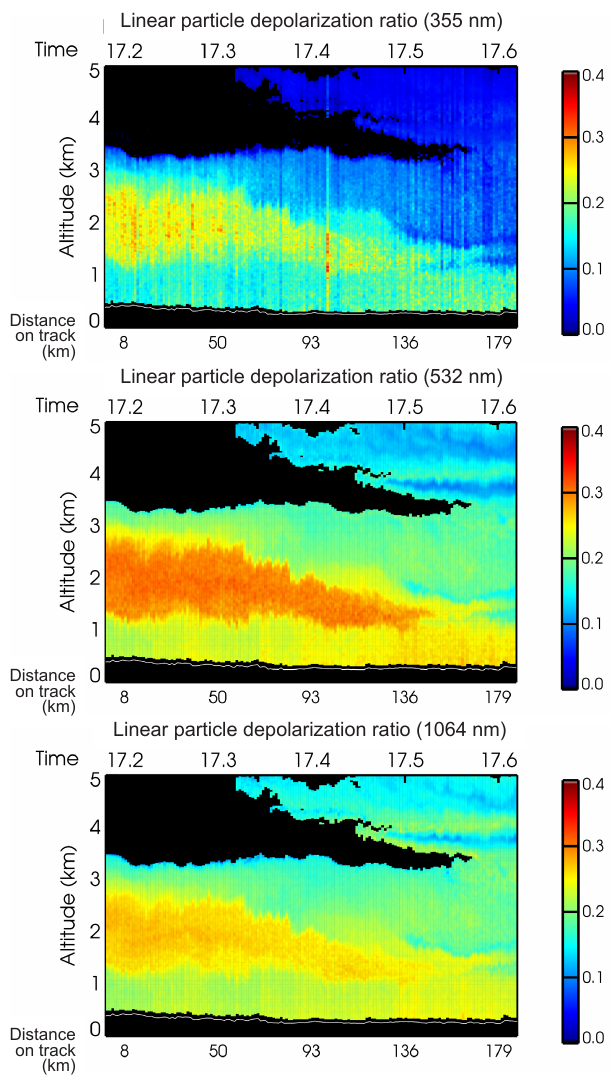
Figure 4. The linear particle depolarization ratio at three wave- lengths measured by the HSRL-2 for the same flight segment shown in Fig.